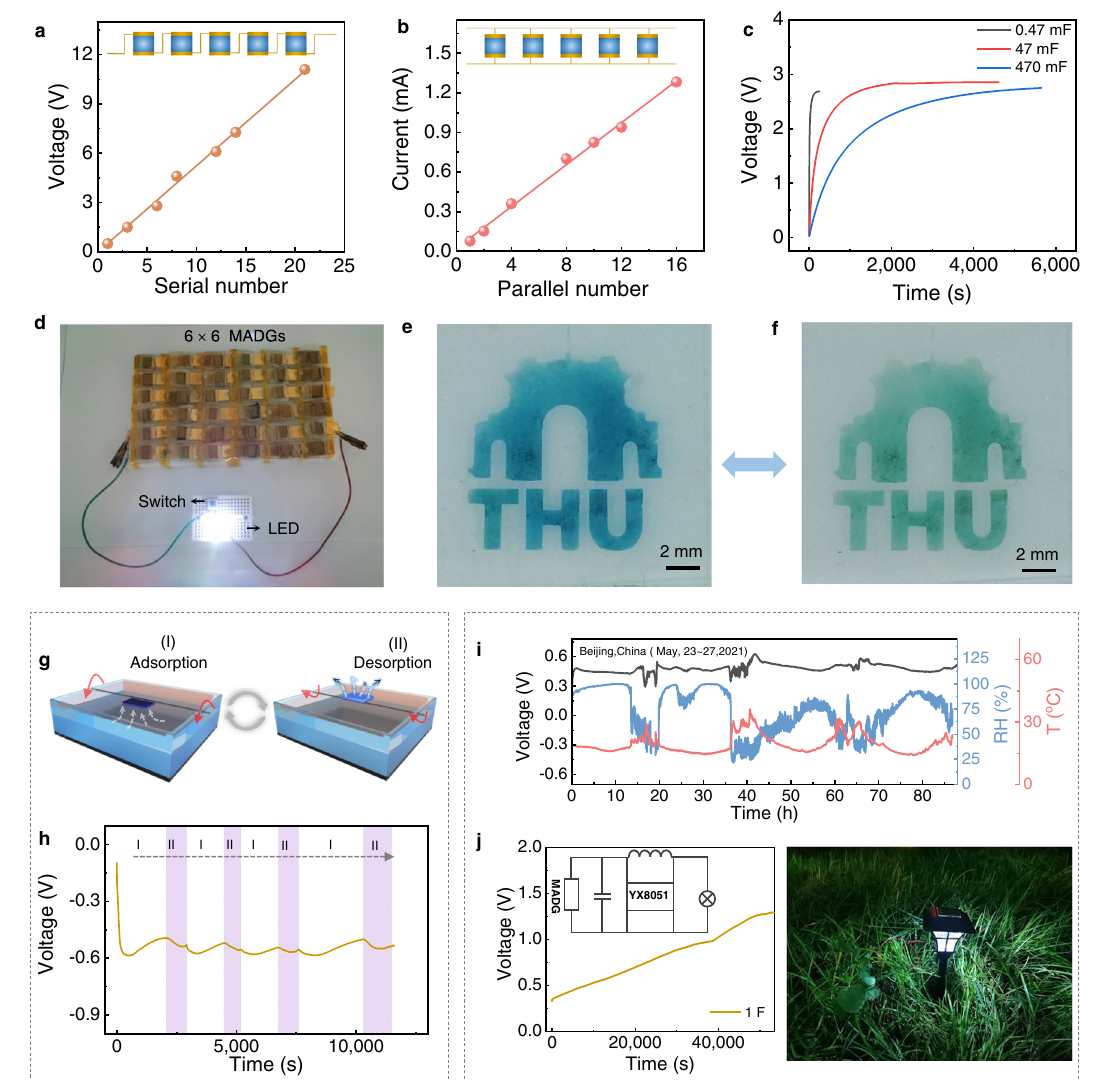
Fig. 7 Applications of MADG. a The relationship between open-circuit voltage and serial number of MADG units. The inset is the serial circuit. b Plot of short-circuit current with different number of MADG units in parallel. The inset is parallel circuit. c Voltage-time curves of commercial capacitors with various capacitance (0.47, 47 and 470 mF) charged by MADGs. d White LED powered by 6 × 6 integrated MADG device (90 ± 10% RH and 35 ± 5 o